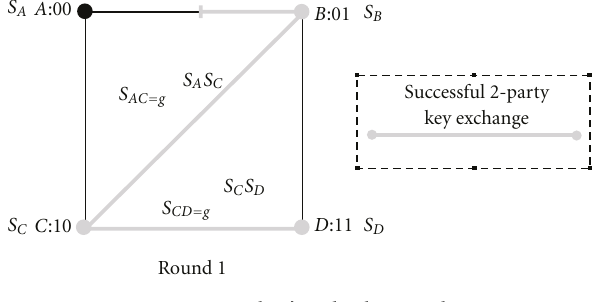
Figure 2: Asokan’s 2-d cube round 1.